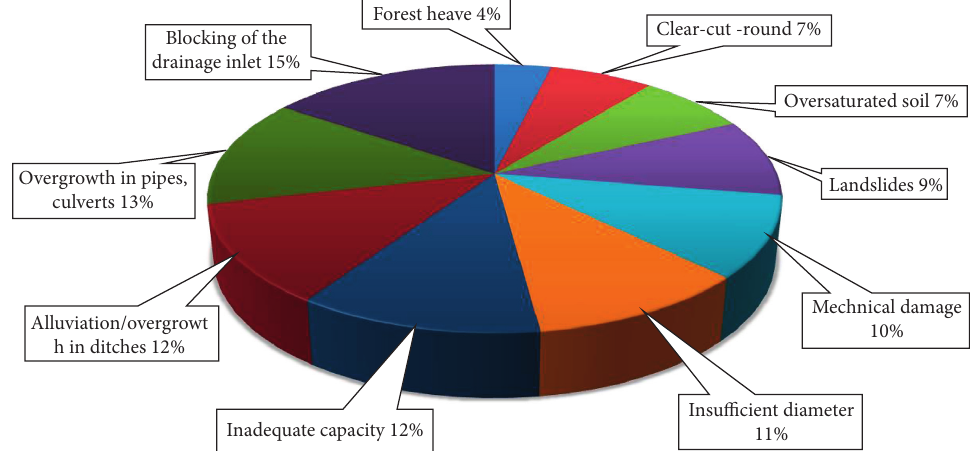
Figure 5: Scoring of different factors linked to real road drainage performance (redrawn from